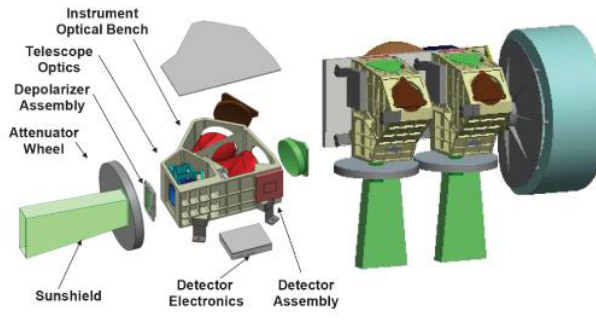
Figure 8. RS Spectrometer exploded view